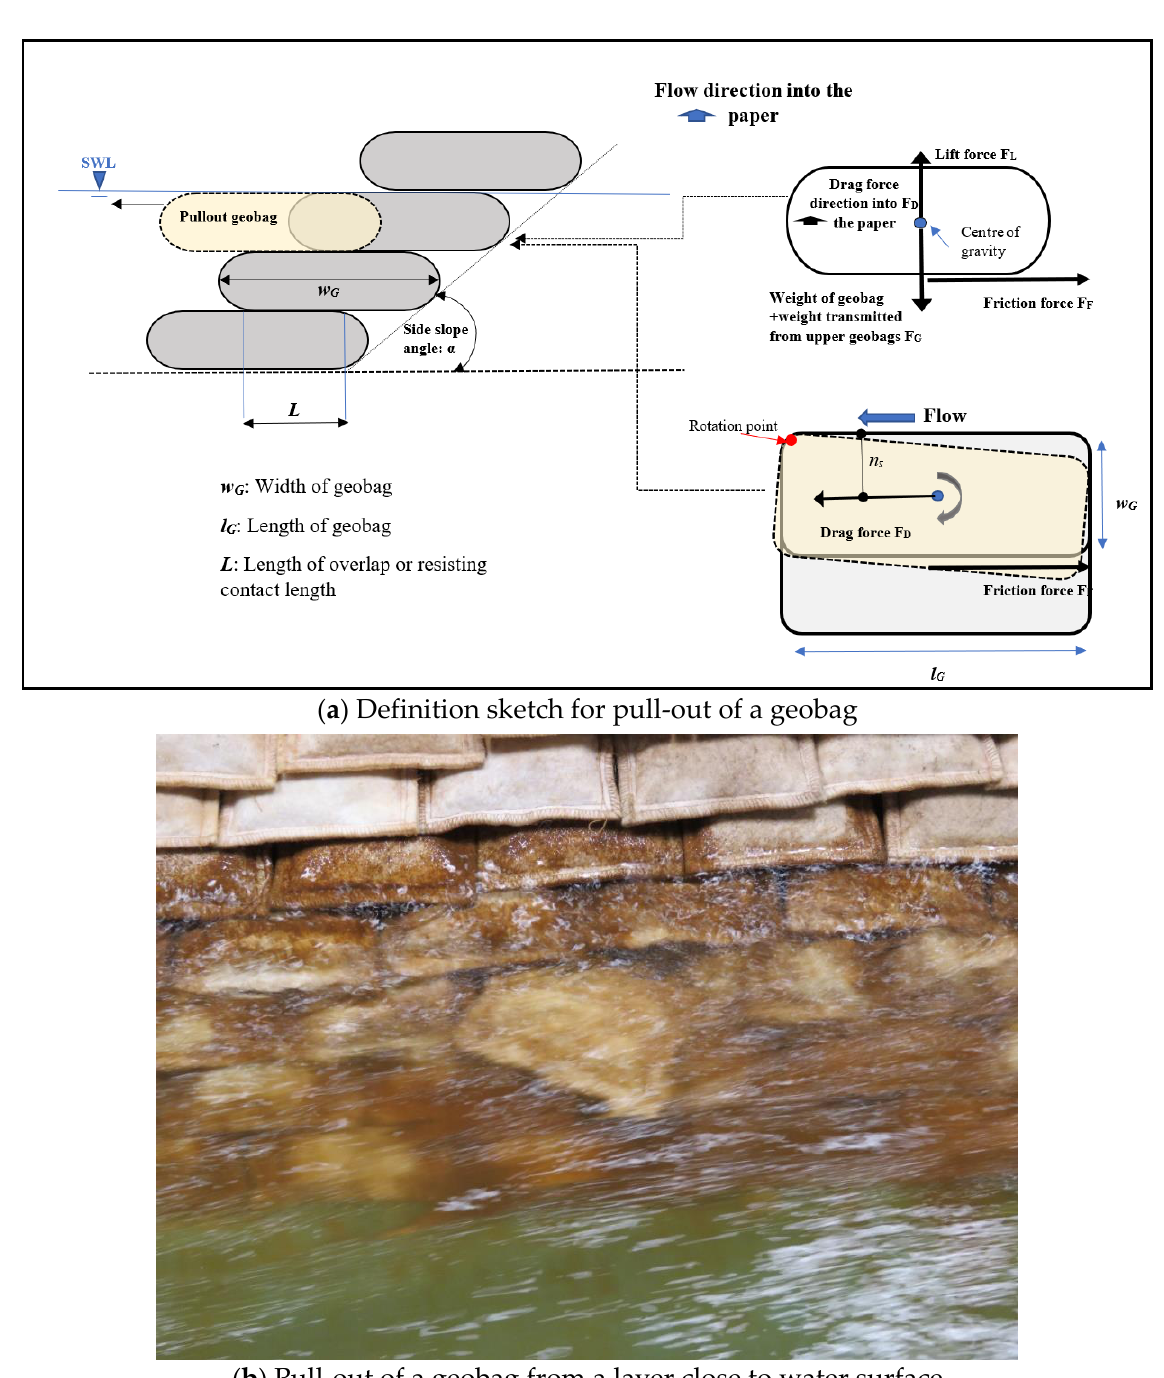
Figure 6. Failure due to pull-out.